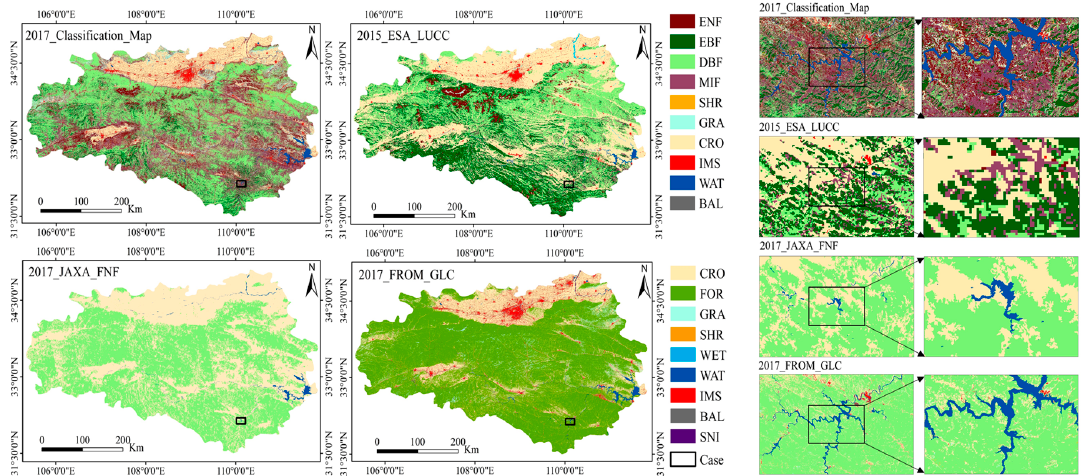
Figure 8. Comparison of the classified map in 2017, European Space Agency Climate Change Initiative Land Cover (ESA_CCI_LC) in 2015, Japan Aerospace Exploration Agency Forest/Non-Forest (JAXA_FNF) in 2017, and Finer Resolution Observation and Monitoring Global Land Cover (FROM_GLC) in 2017 in a case region.